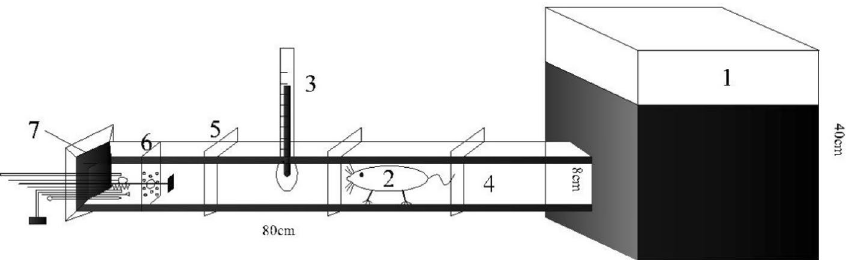
Figure 1. Schematic drawing of the setup used to test burrow-sealing behavior in plateau zokors in the laboratory. (1) acrylic box covered with soil 30 cm in depth; (2) experimental animal; (3) mercury thermometer;